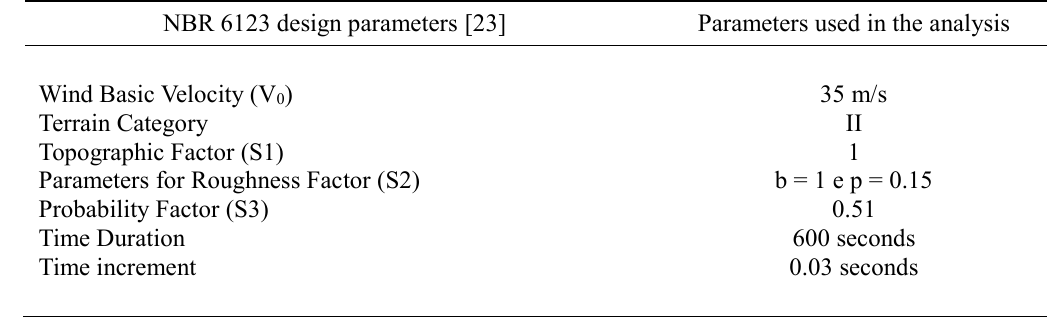
Parameters used to generate the nondeterministic wind